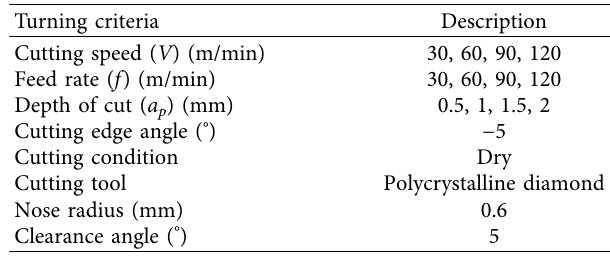
Table 3: Turning criteria.